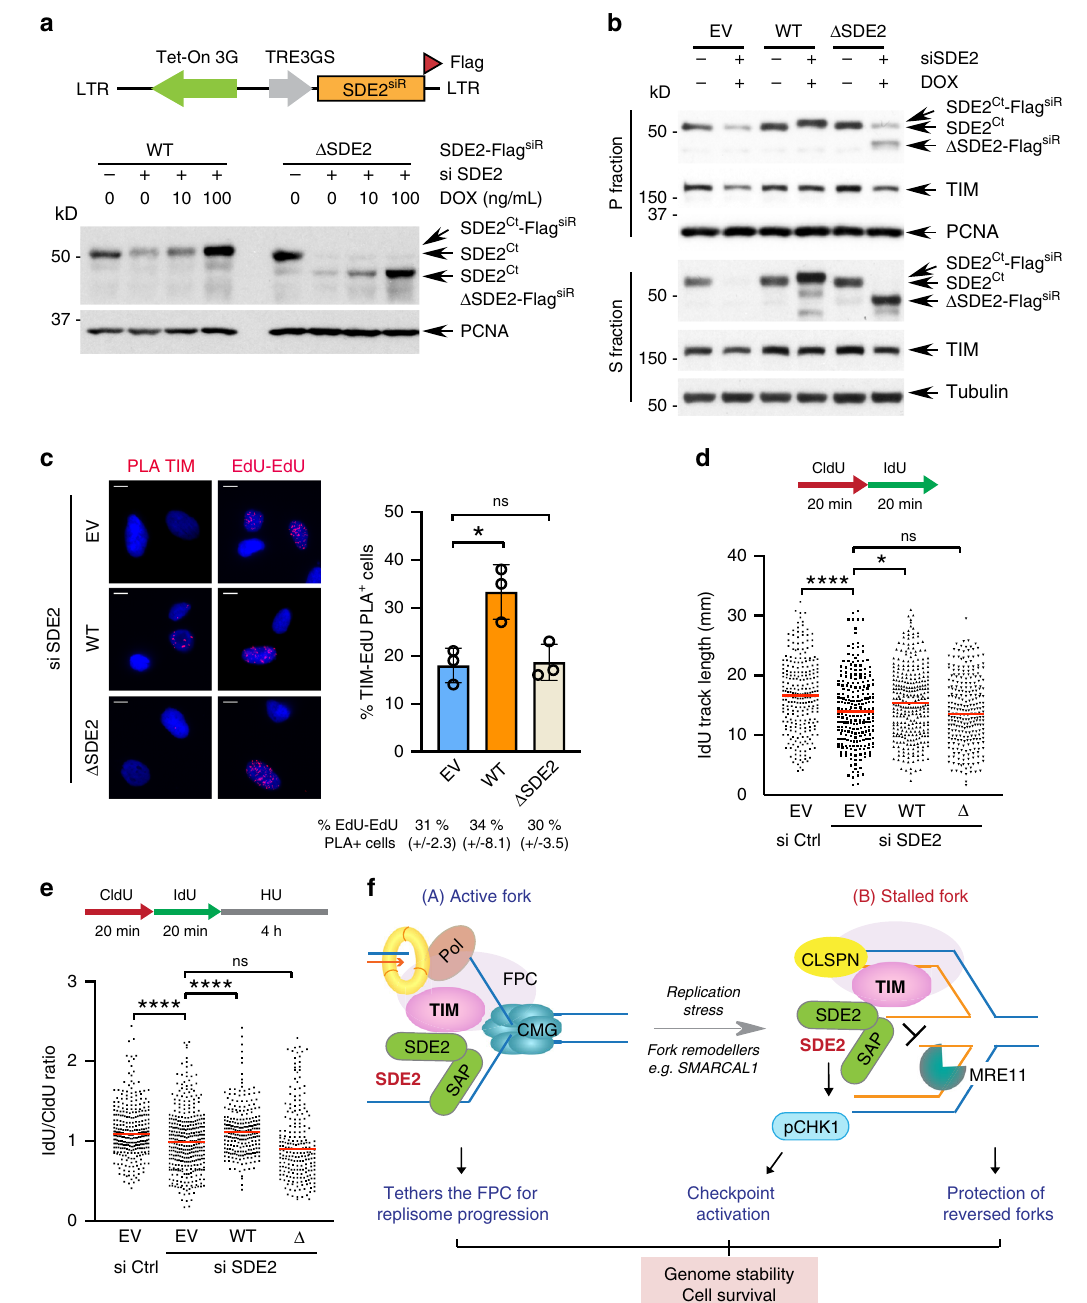
Fig. 7 SDE2-TIM interaction is required for protecting replication forks. a Top: schematic of the Retro-X Tet-One system to express siRNA-resistant (siR) SDE2-Flag WT or Δ SDE2 mutant under the control of the doxycycline (dox)-inducible P TRE3GS promoter. Bottom: induction of Flag-tagged SDE2 WT or Δ SDE2 in response to increasing dose of dox, following transfection of SDE2 siRNA (vs. control). b TIM levels in S and P fractions from U2OS cells reconstituted with SDE2-Flag WT or Δ SDE2. See Fig. S7A for quanti fi cation. c Left: representative images of TIM:EdU PLA foci in the Retro-X SDE2 WT or Δ SDE2 cells following SDE2 siRNA transfection and dox induction. Scale bar, 10 μ m. Right: quanti fi cation of cells positive for TIM:EdU PLA foci. (>100 cells per condition, n = 3 biologically independent experiments, mean ± SD, * P < 0.05, Student ’ s t-test). d Dot plot of the DNA fi ber IdU track length from the Retro-X U2OS cells reconstituted with SDE2 WT or Δ SDE2. (>200 tracks per condition, n = 2 biologically independent experiments, **** P < 0.0001, * P < 0.05, Mann – Whitney). e Dot plot of the DNA fi ber IdU/CldU track length ratio from the Retro-X U2OS cells treated with 4 mM HU for 4 h ( n = 3 biologically independent experiments, **** P < 0.0001, Mann – Whitney). f A model depicting the role of SDE2 in promoting TIM-dependent fork protection, coordinated at both active and stalled forks. See discussion for